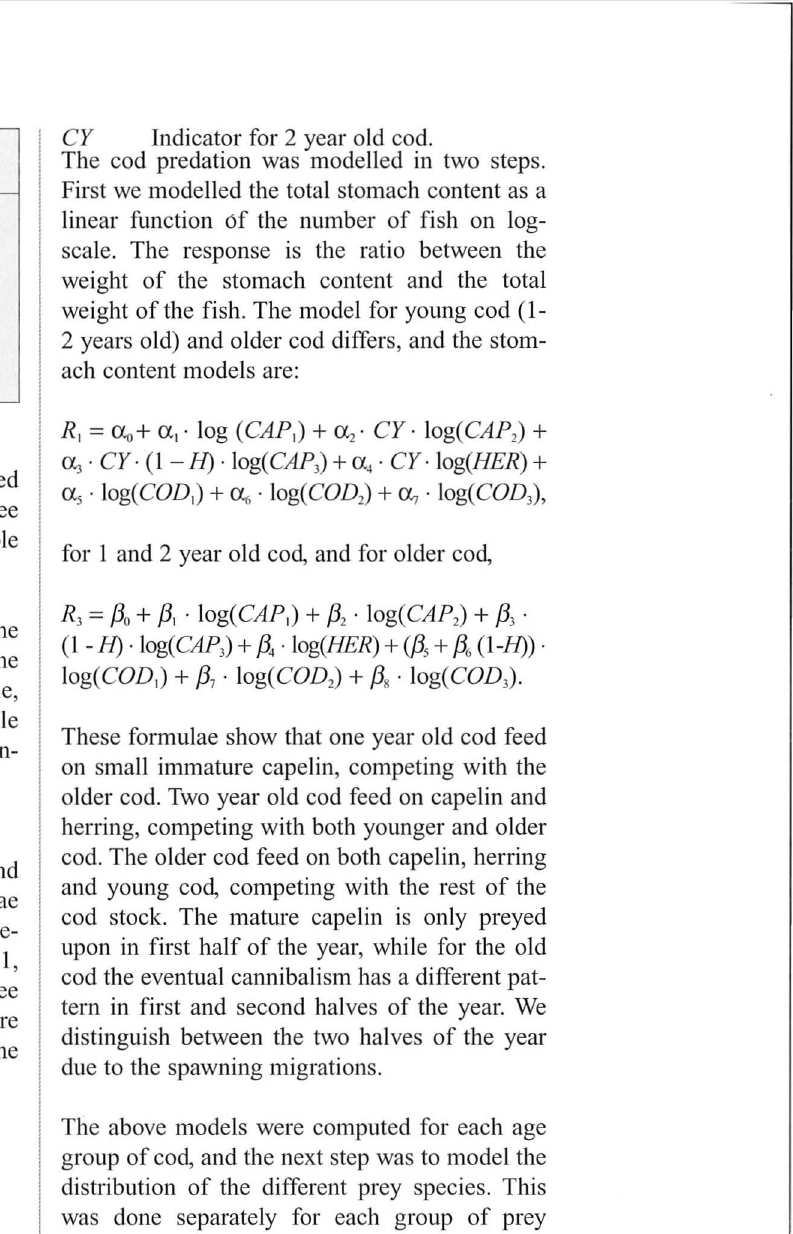
Table 3: Predation parameter estimates found in the Appendix. BIOmass IS measured in million tonnes